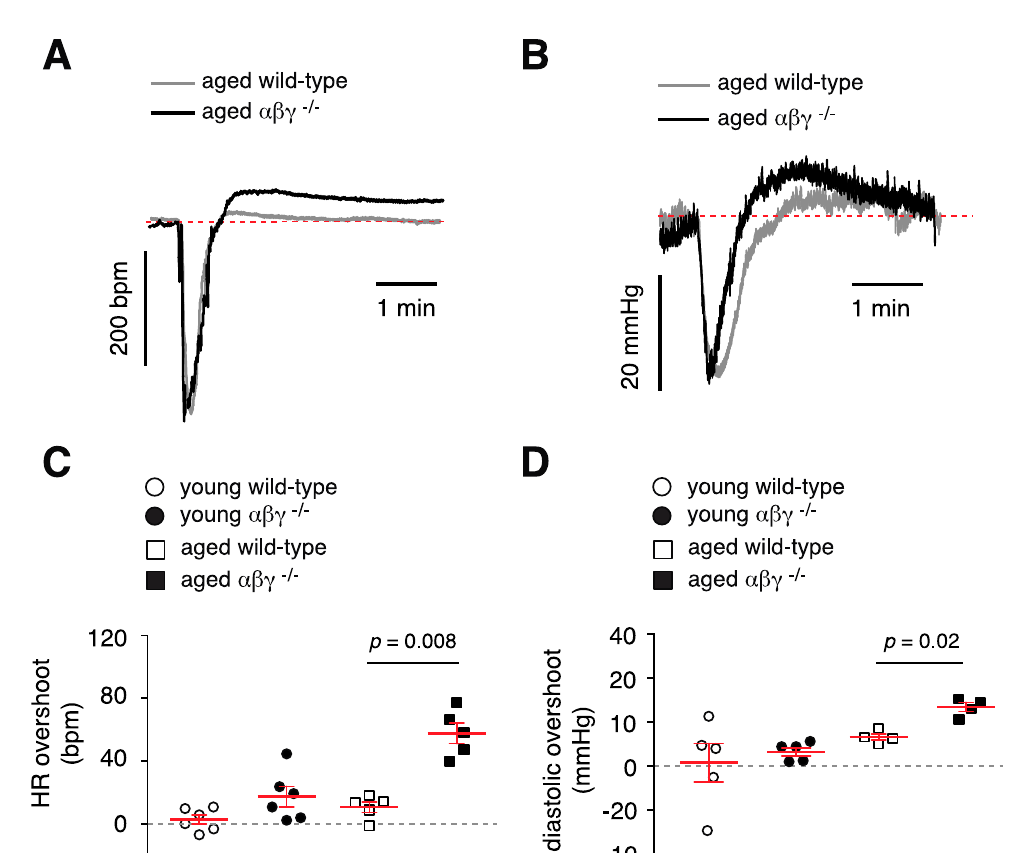
Figure 5. Heart rate and diastolic blood pressure restoration in αβγ − / − mice. ( A ) Example trace showing heart rate after activation of the depressor reflex in aged wild-type and αβγ − / − mice. ( B ) Example trace showing diastolic blood pressure after activation of the pressor reflex in aged wild-type and αβγ − / − mice. ( C ) Combined data showing maximum change (overshoot) in heart rate above baseline after activation of the depressor reflex in aged, young wild-type and αβγ − / − mice). ( D ) Combined data showing maximum change in diastolic blood pressure above baseline after activation of the pressor reflex in aged, young wild-type and αβγ − / − mice. Means ± S.E.M were compared with a Mann–Whitney U rank test.